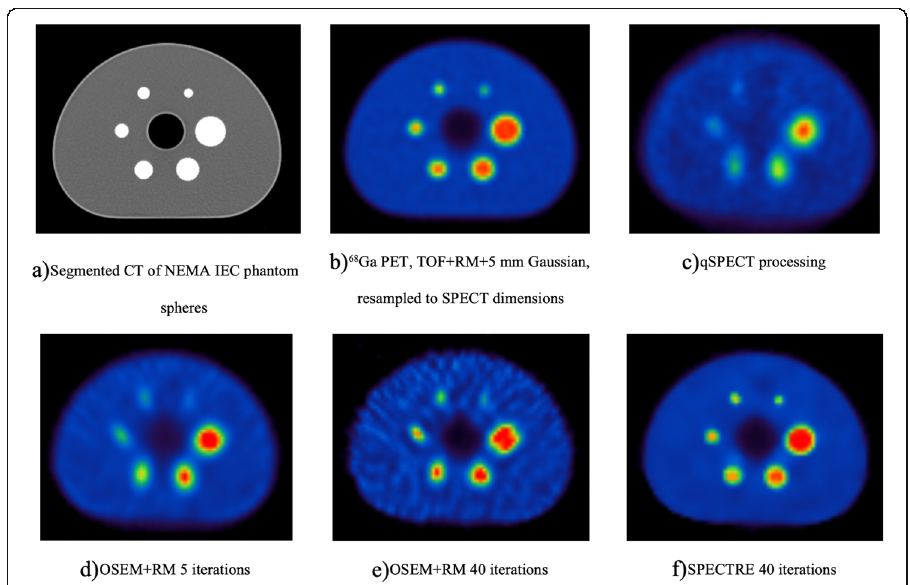
Fig. 1 Transverse centre slice of IEC image quality phantom for each reconstruction method. a CT image (segmented spheres), b 68 Ga PET, TOF + RM + 5 mm Gaussian, resampled to SPECT dimensions and used as prior image used in the SPECTRE reconstruction. c Our in-house routine qSPECT-OSEM reconstruction (4 iterations and 8 subsets), d OSEM + RM reconstruction (5 iterations and 12 subsets), e OSEM + RM reconstruction (40 iterations and 12 subsets), and f SPECTRE with RM [HKEM parameters: σ p = 2, σ s = 2, σ dp = 5, σ ds = 5, NN = 5] (40 iterations and 12 subsets)